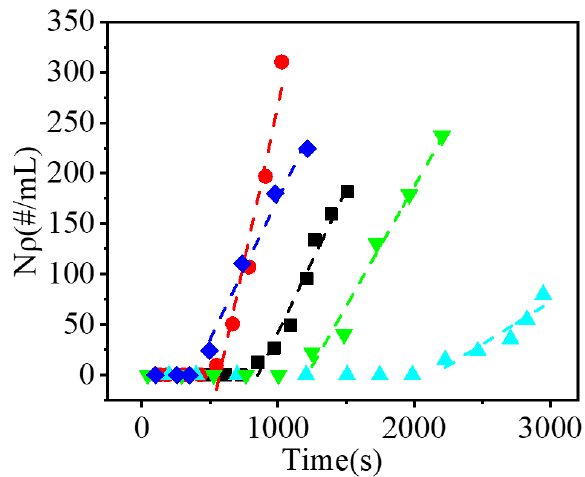
Figure 3. Secondary nucleation process of AIBN in methanol. All the data shown in Figure 3 were obtained at 293.15 K with stirring at 200 rpm. The red circles, black squares and cyan up-triangles represent the N ρ of AIBN in experiments at supersaturation levels of 1.08, 1.06, and 1.02 with 5 crystal seeds, respectively. The green down-triangles and blue rhombuses represent the N ρ of AIBN in experiments with 1 and 20 crystal seeds at a supersaturation of 1.06, respectively.